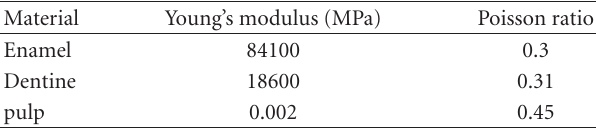
Table 1: Mechanical properties of all materials included in the FE